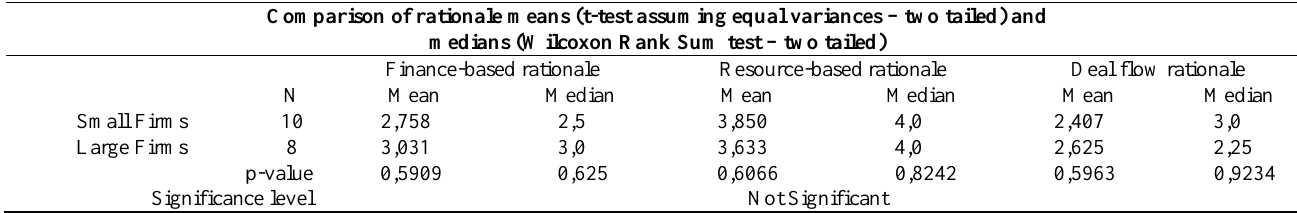
Table 4: Comparison of rationales for syndication: Small vs. Large firms Comparison of rationale means (t-test assuming equal variances – two tailed)